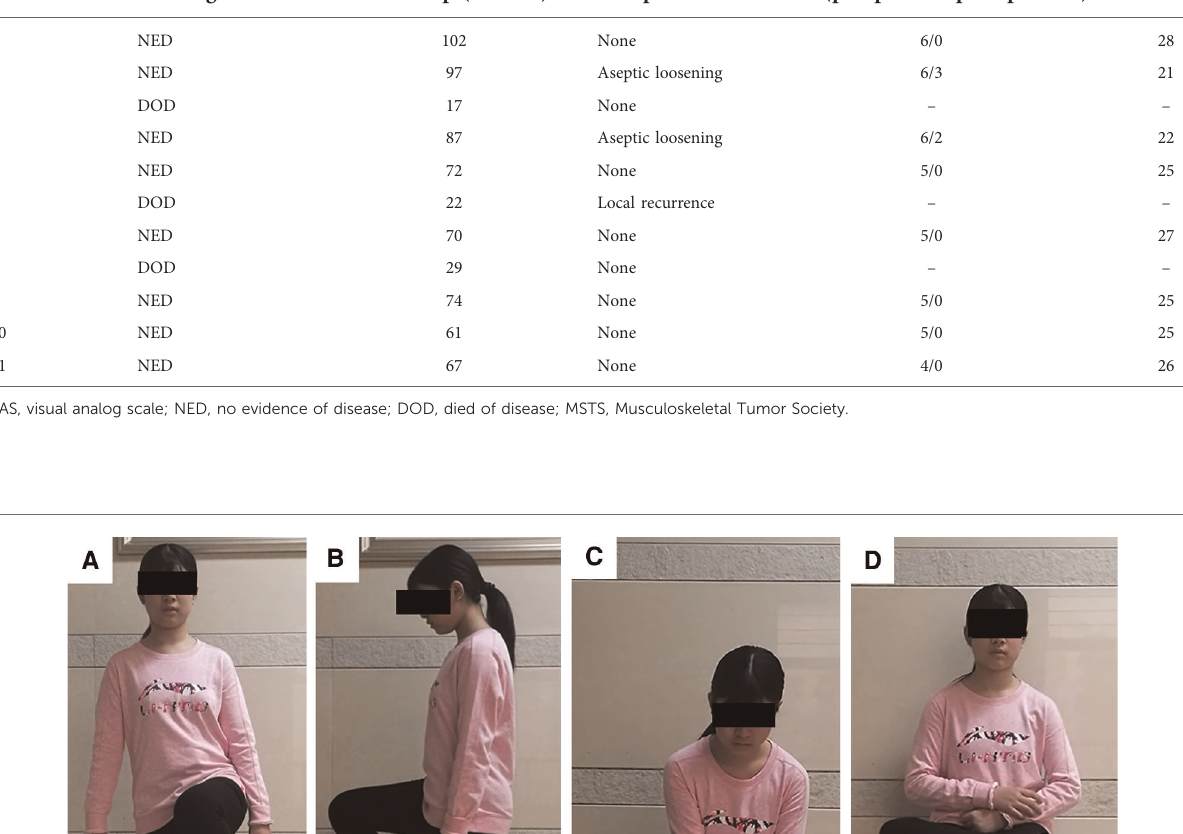
TABLE 3 Results for patients undergoing distal femoral reconstruction with an intra-neck curved stem endoprosthesis. Patient no Oncological status